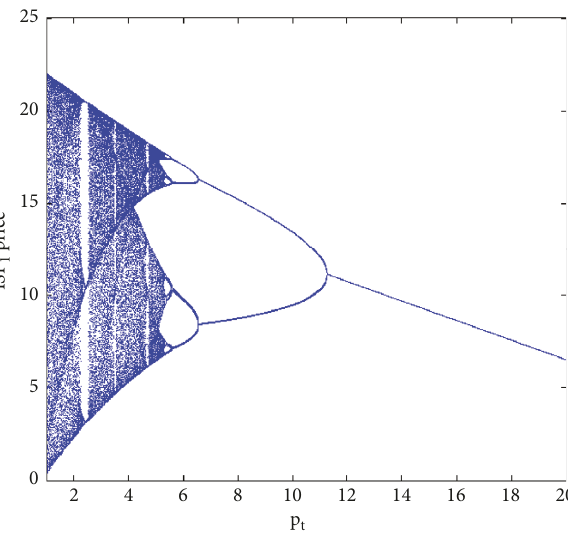
Figure 3: Bifurcation diagrams of p